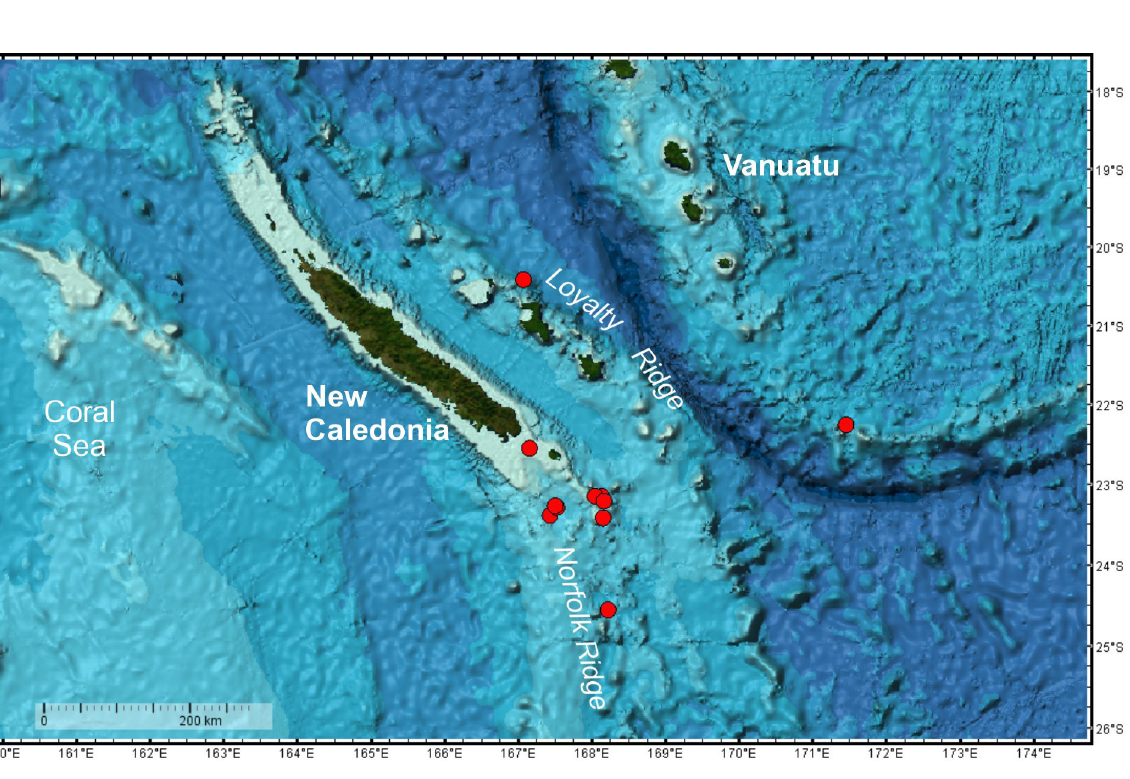
Fig. 17. Distribution map for Profundiconus neocaledonicus sp. nov. Red circles indicate the points where the species has been